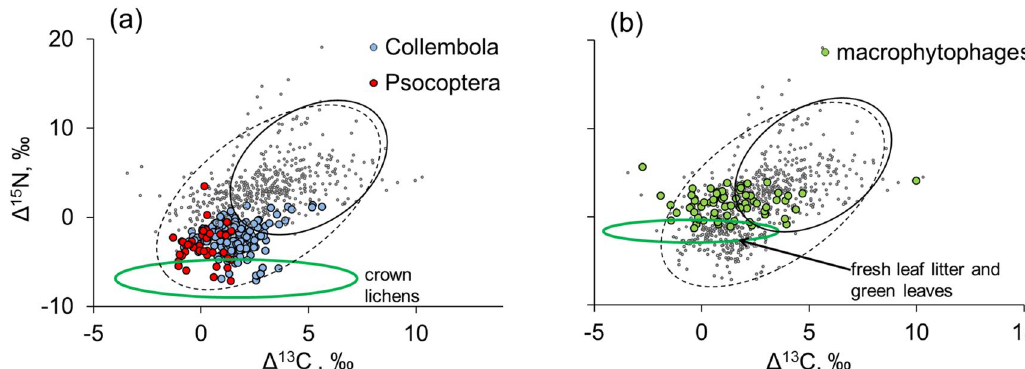
Figure 3. Isotopic composition (litter-normalized Δ 13 C and Δ 15 N values) of Collembola and Psocoptera ( a ) and macrophytophages ( b ) from the arthropod rain and of presumed food sources (lichens and green leaves and fresh leaf litter, green ellipses). Other animals forming arthropod rain are shown as gray dots. Each point is one specimen or several conspecifics. Standard ellipses for the arthropod rain and soil-dwelling invertebrates are shown as dashed and solid black lines, respectively.